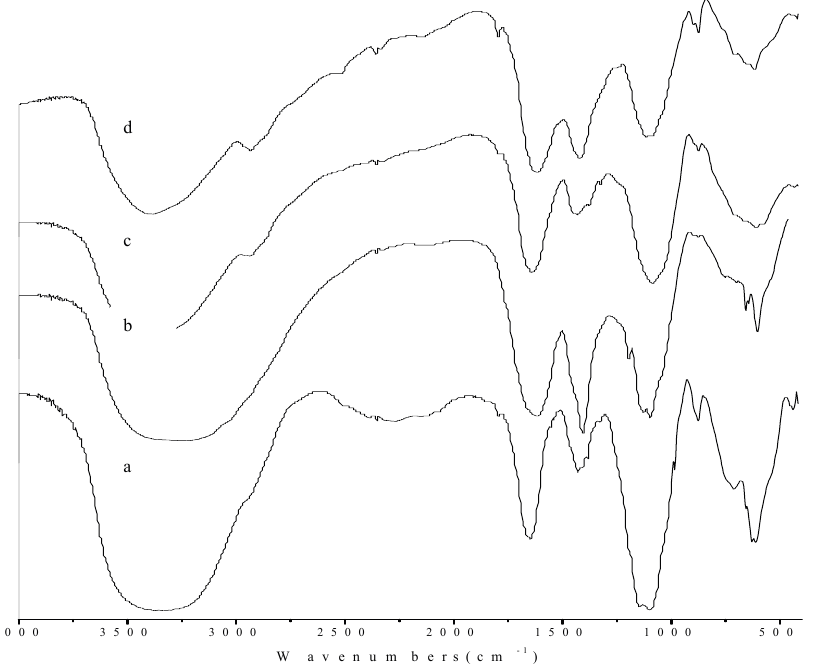
Figure 6. FTIR of PBLPS-1 from the four varieties of bamboo leave: (a) PBLPS-1 of Phyllostachys nigra (PN); (b) PBLPS-1 of Phyllostachys vivax (PV); (c) PBLPS-1 of Chimonobambusa quadrangularis (Fenzi) Makino (CQ); (d) PBLPS-1 of Phyllostachys bambusoides